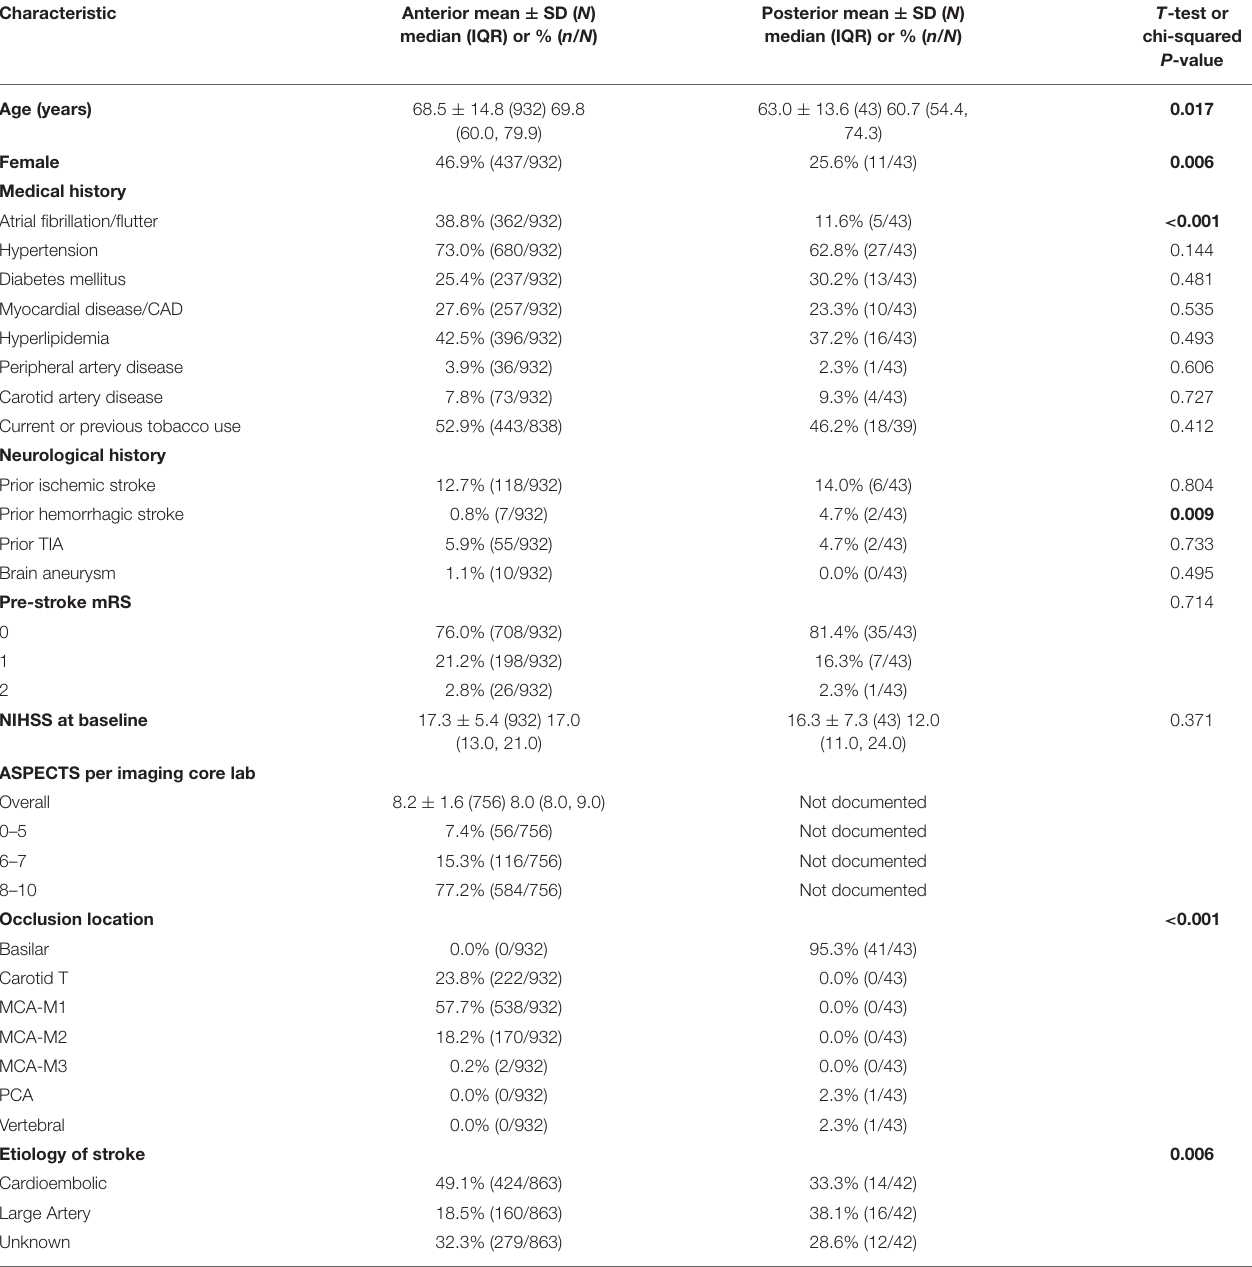
Bold values represent statistically significant differences. SD, standard deviation; IQR, interquartile range; CAD, coronary artery disease; TIA, transient ischemic attack; mRS, modified Rankin Scale; NIHSS, National Institutes of Health Stroke Scale; ASPECTS, Alberta Stroke Program Early CT Score; ICA, internal carotid artery; MCA, middle cerebral artery; PCA, posterior cerebral artery.